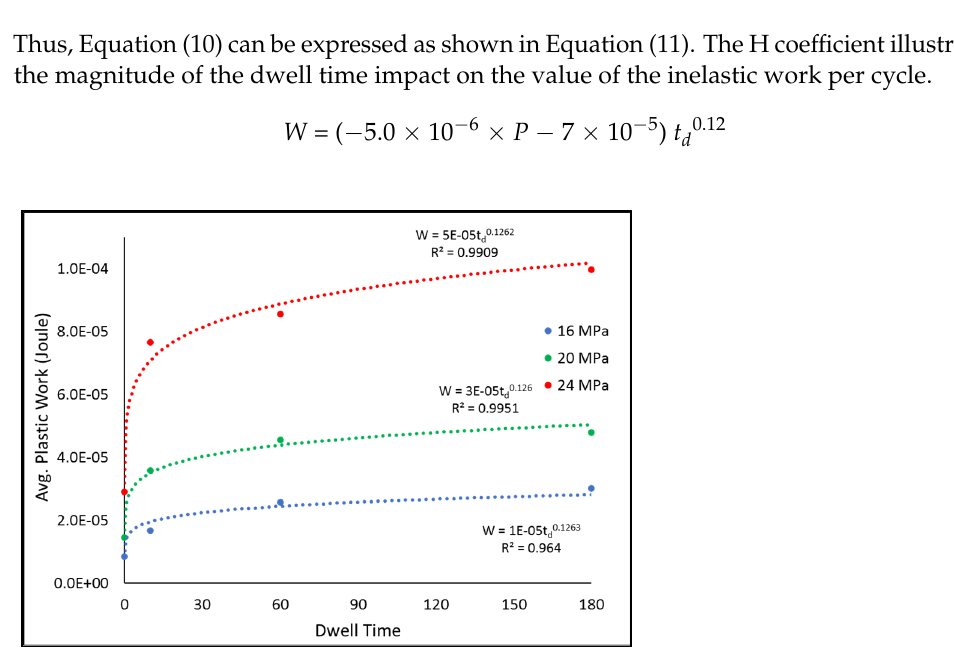
Figure 30. Inelastic work per cycle as a function of dwelling time curves at various stress levels.